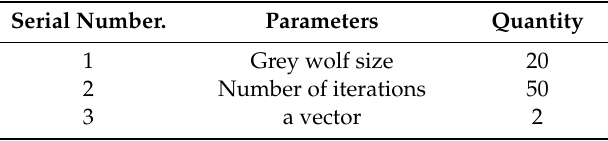
Table 1. Grey wolf algorithm parameters.